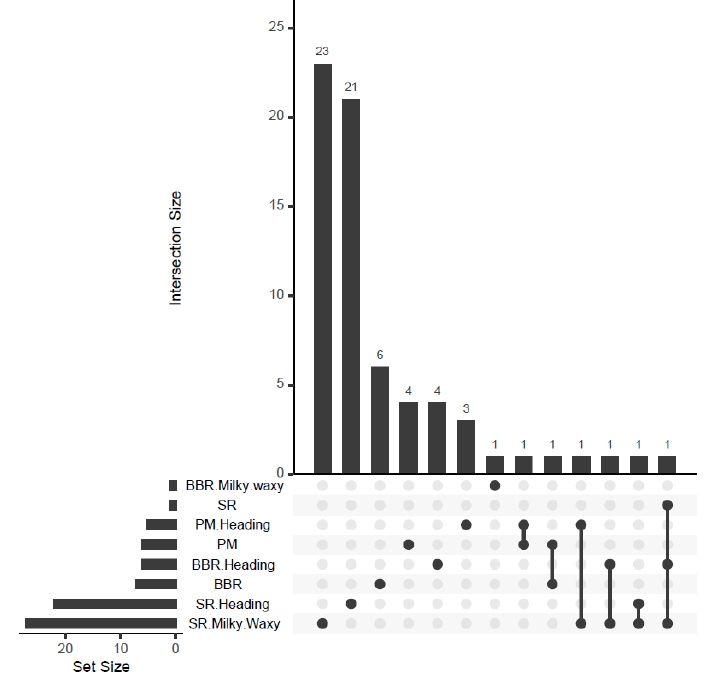
Figure 11. UpSet plot showing the number of marker–trait associations (MTAs) identified via GWAS. Markers identified as significant for more than one trait are shown as intersects between sets. Table 4. Significant marker–trait associations (MTAs) for resistance to powdery mildew (PM) at heading stage (PM_HA) and maximum disease scores across all replicates 2018–2019.